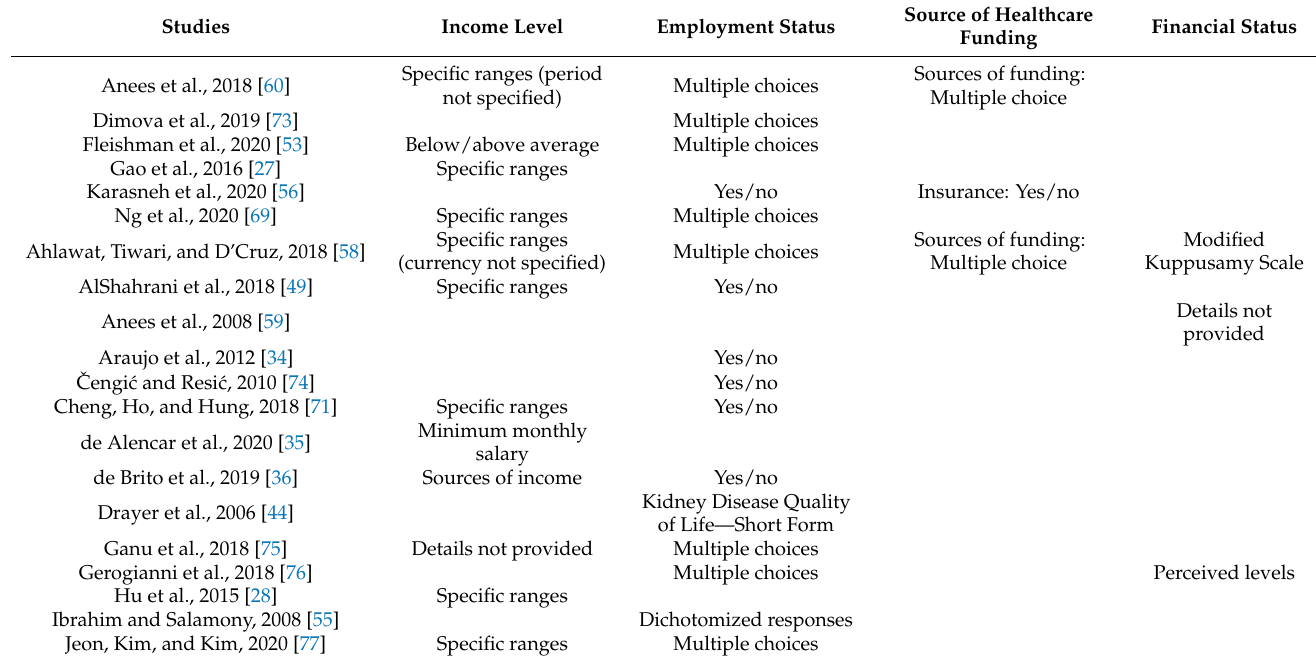
Table 3. Assessment of financial